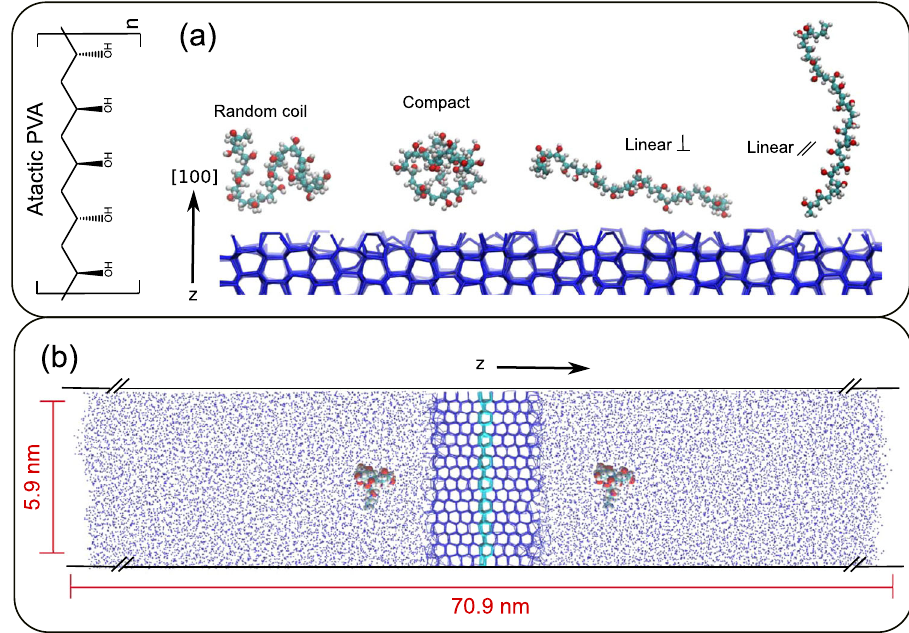
Fig. 1 Computational set-up. a Molecular structure of PVA along with representative con fi gurations of the simulated polymers. Random coil refers to the polymer simulations that do not have their radius of gyration ( R g ) restrained, compact and linear refer to simulations in which the R g has been restrained to a de fi ned value (see Methods section). For the linear polymers, their orientation with respect to the direction (z) of the growing ice front is also restrained, either perpendicular or parallel to the z -axis. b Representative snapshot of the computational geometry. The restrained seeded ice layer is highlighted in cyan. The ice front presenting the primary prismatic face to the water phase grows in the ±z